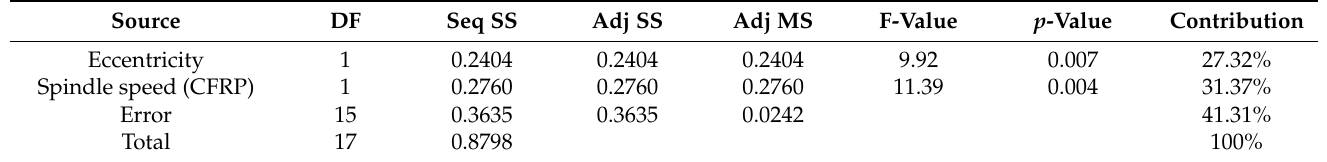
Table 7. Analysis of variance of surface roughness of